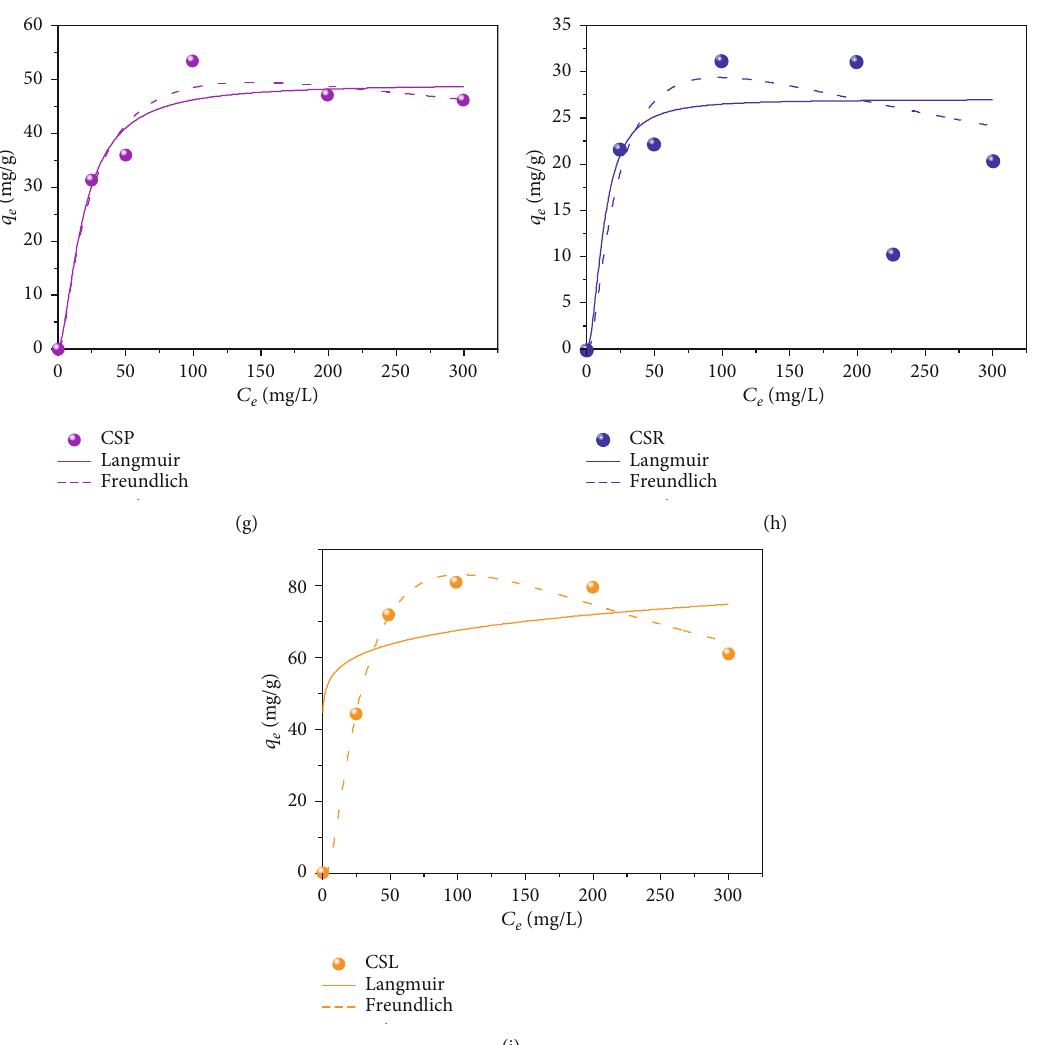
Figure 10: Sorption isothermsfor sulfadiazine (a – c), the oil-water solution (d – f), and methylene blue(g – i) with di ff erentparts of the corn